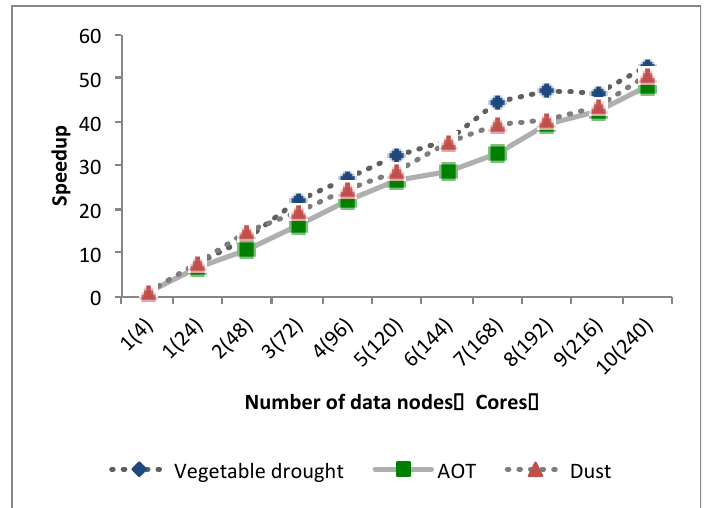
Figure 2. Speed of various models on Hadoop (1 to 10 nodes) with increasing numbers of nodes.